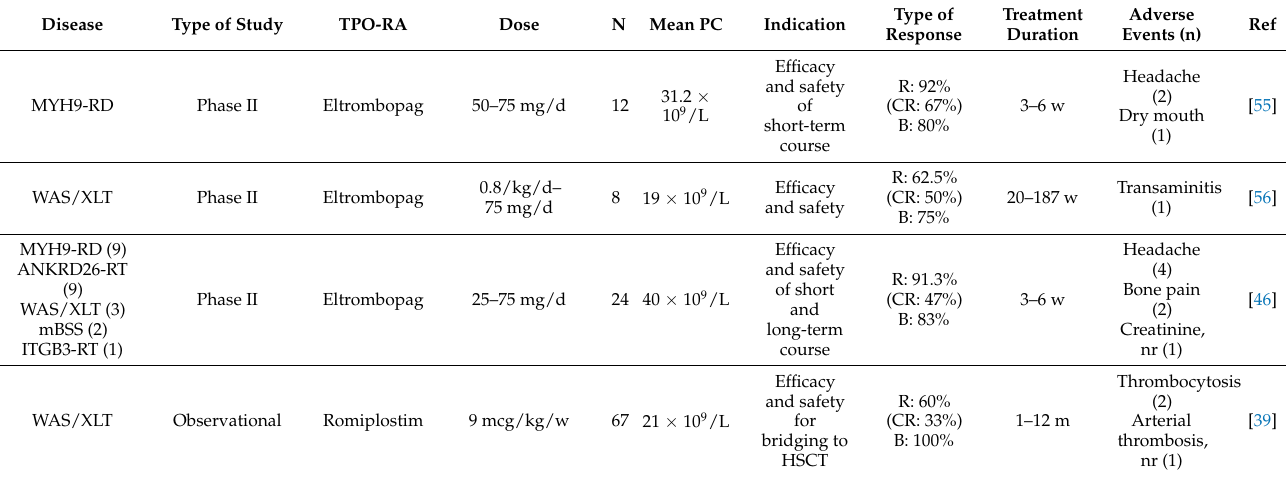
Table 2. Clinical trials including patients with inherited thrombocytopenia treated with TPO-RA.